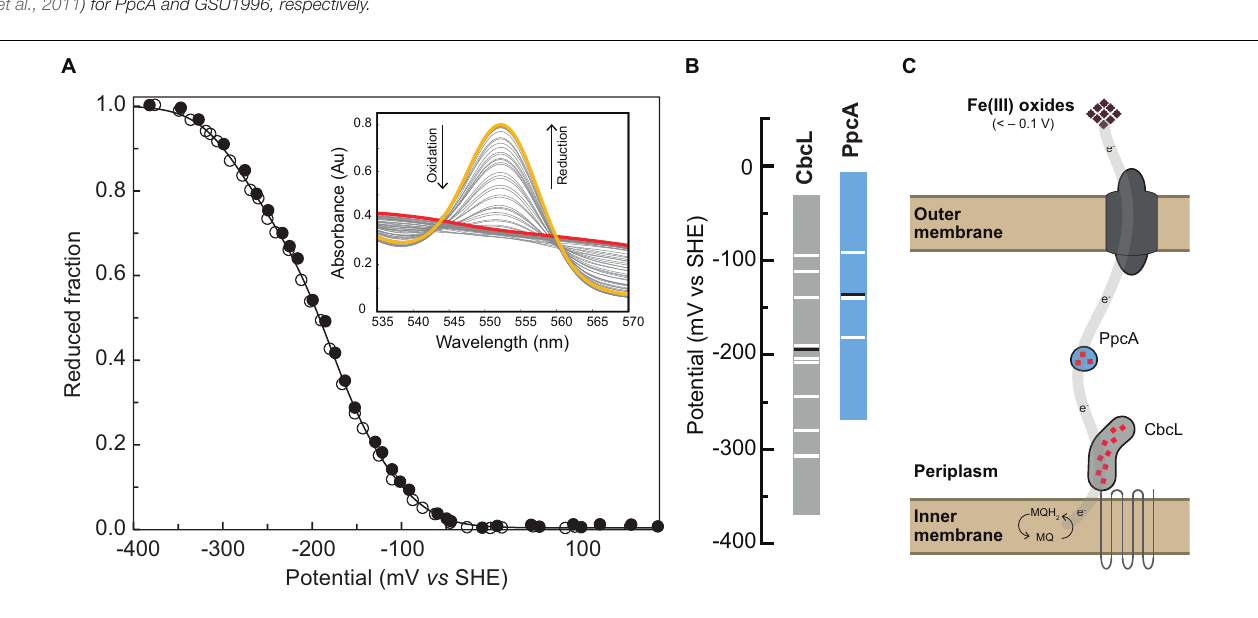
The percentage of secondary structure elements of CbcL was determined by CD spectroscopy in the far-UV region. Data for PpcA and GSU1996 is also presented for comparison.